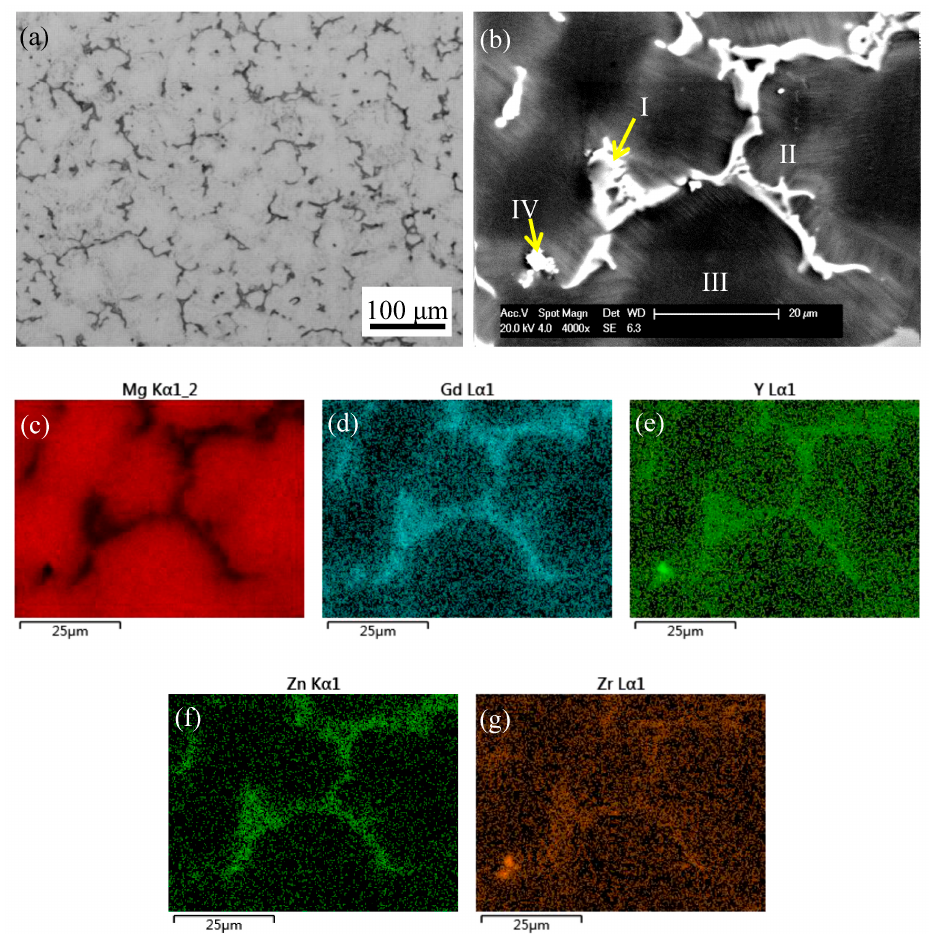
Figure 3. ( a ) Optical and ( b ) SEM (scanning electron microscope) micrographs of as-cast alloy with element map distributions of ( c ) Mg, ( d ) Gd, ( e ) Y, ( f ) Zn, and ( g ) Zr, respectively.